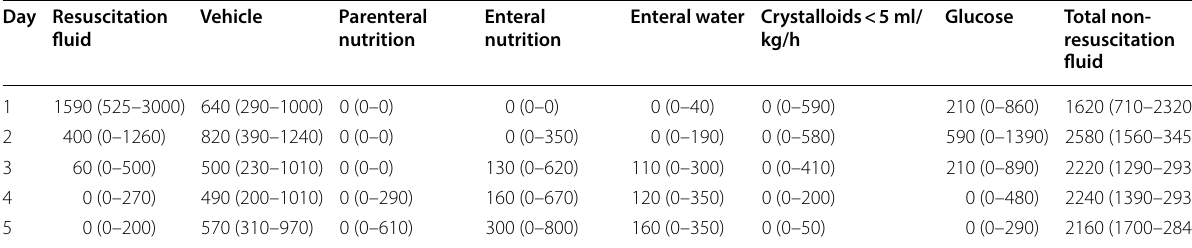
Volumes are presented as median (IQR). Please note that the sum of the daily medians of the different components of non‑resuscitation fluids does not equal the median of the daily total volume of non‑resuscitation fluids due to the skewed distribution of the data